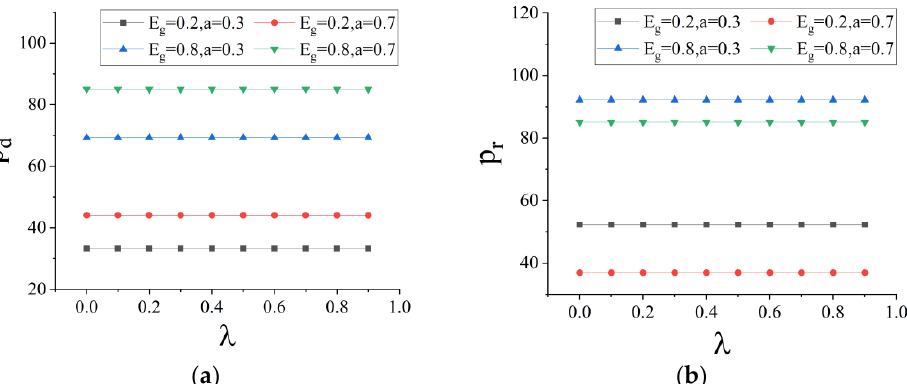
Figure 3. The impact of fairness concerns of manufacture on online direct selling price and offline direct selling price. ( a ) The impact of fairness concerns of manufacture on online direct selling price; ( b ) The impact of fairness concerns of manufacture on offline direct selling price.